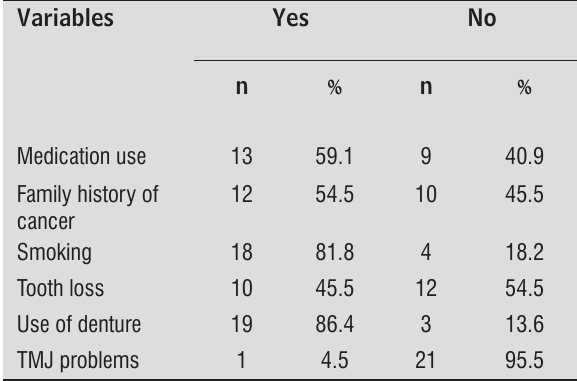
Table 1 - Sample characteristics